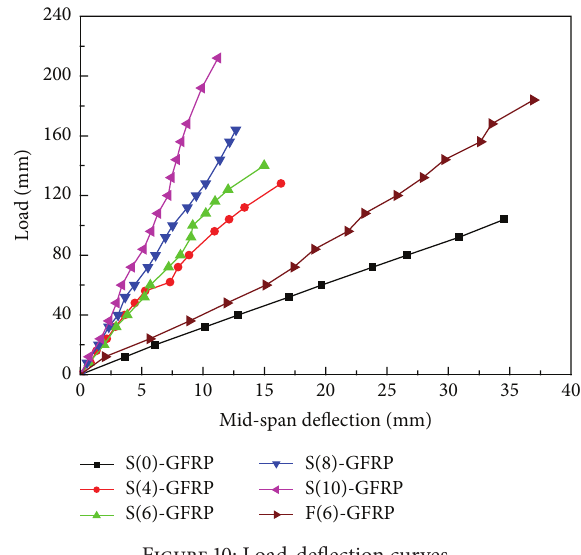
Figure 10: Load-deflection curves.